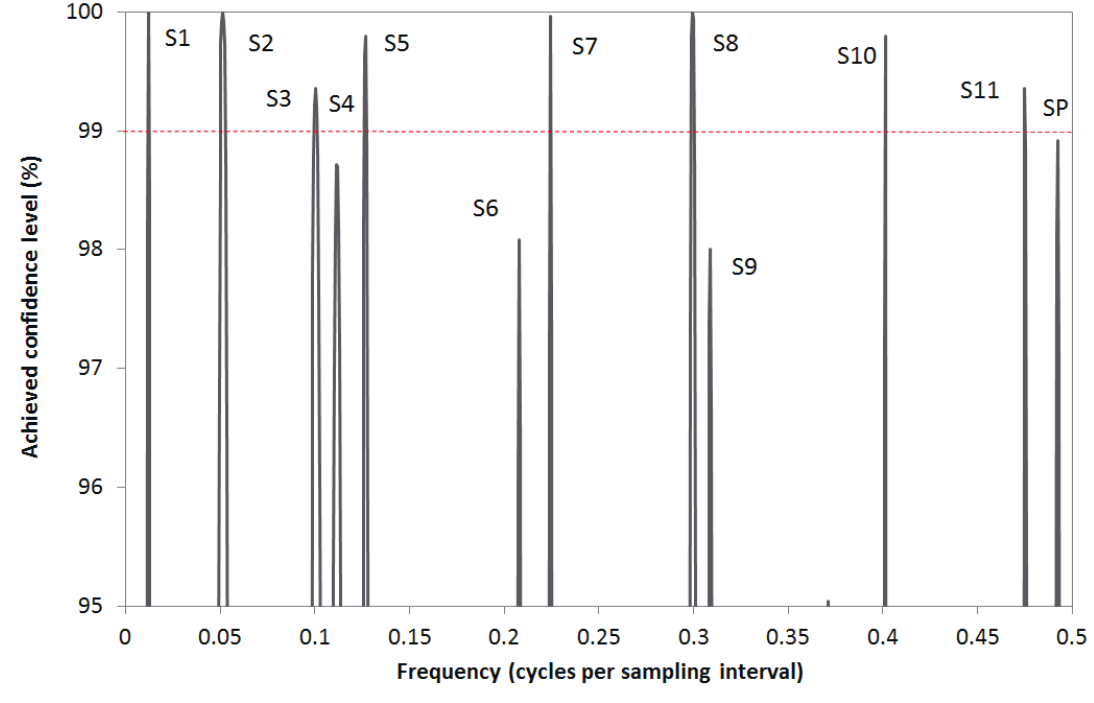
Figure 3. Achieved confidence level of the estimated power spectrum shown in Figure 2. It can be seen that all the spectral peaks have an ACL higher than 95%. There is a spurious peak (SP) in the high frequencies. The Nyquist frequency is 0.5 which corresponds to a period of 2 arbitrary units of